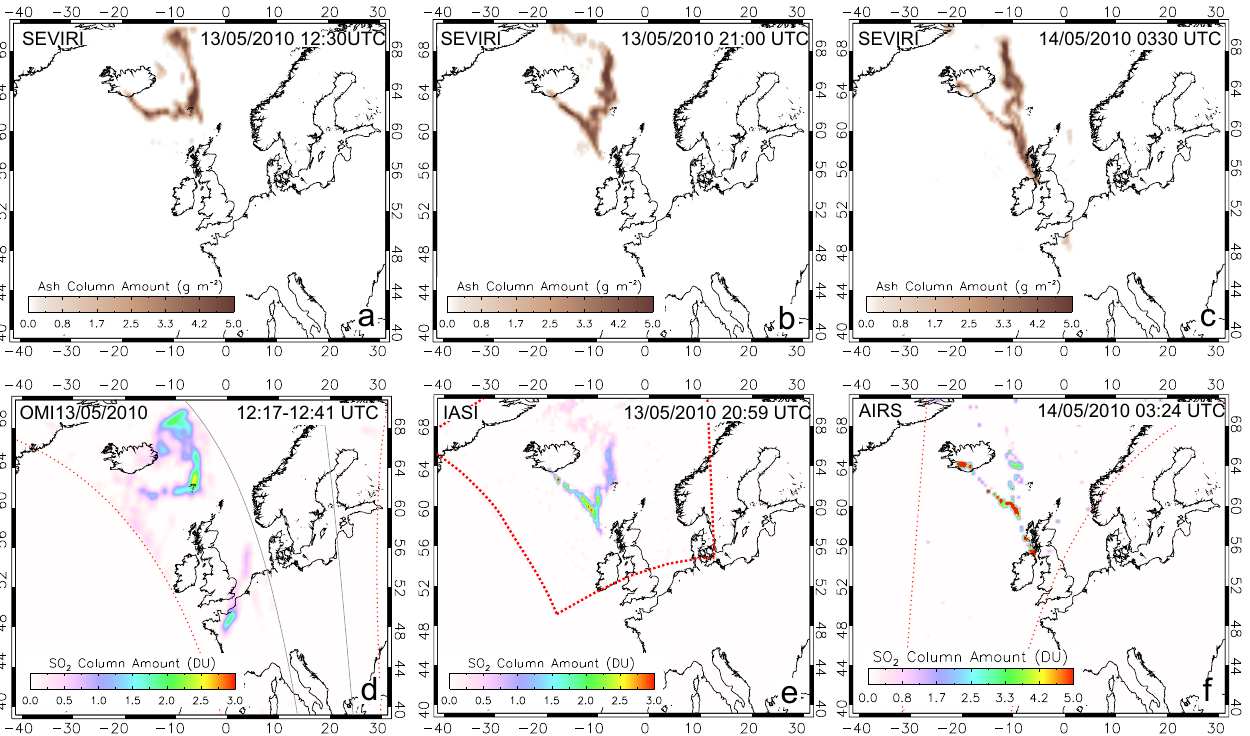
Fig. 7. Ash (a–c) from SEVIRI and SO 2 retrievals (d–e) for the latter half of 13 May and the early morning on 14 May. During this time period the volcanic cloud is seen to make a dramatic change in direction. As before, red dashed lines indicate the edge of swath (or image limits in the case of IASI) of the polar orbiting instruments and the grey lines delimit the OMI row anomaly between which there are no useable data.